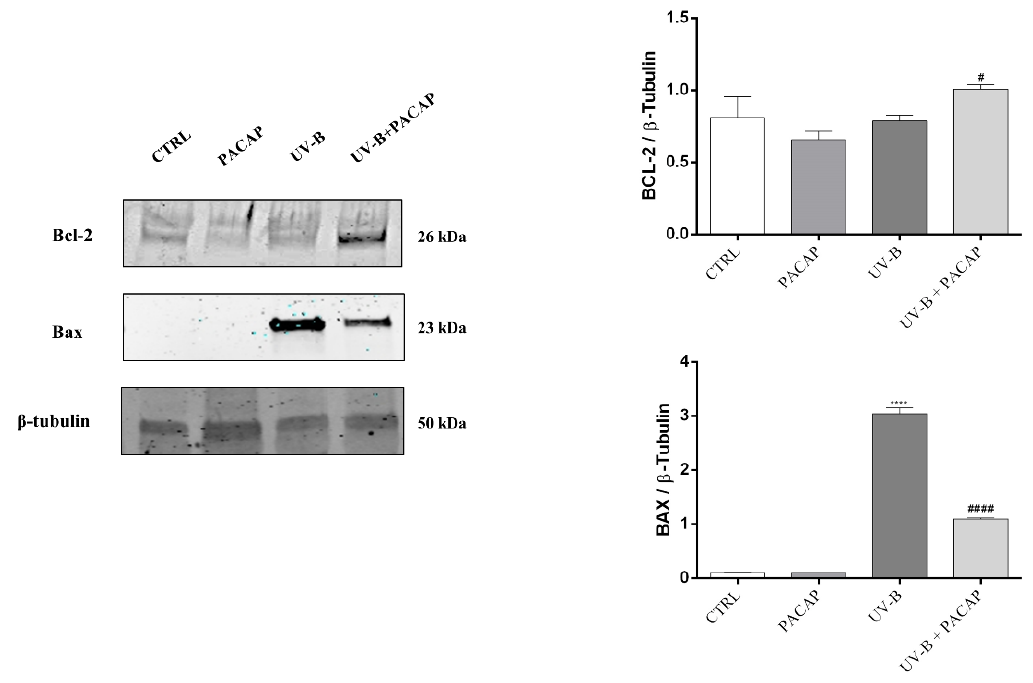
Figure 4. Expression of Bcl-2 and Bax proteins at 24 h in different experimental groups. **** p < 0.0001 vs. CTRL; # p < 0.05, and #### p < 0.0001 vs. UV-B.